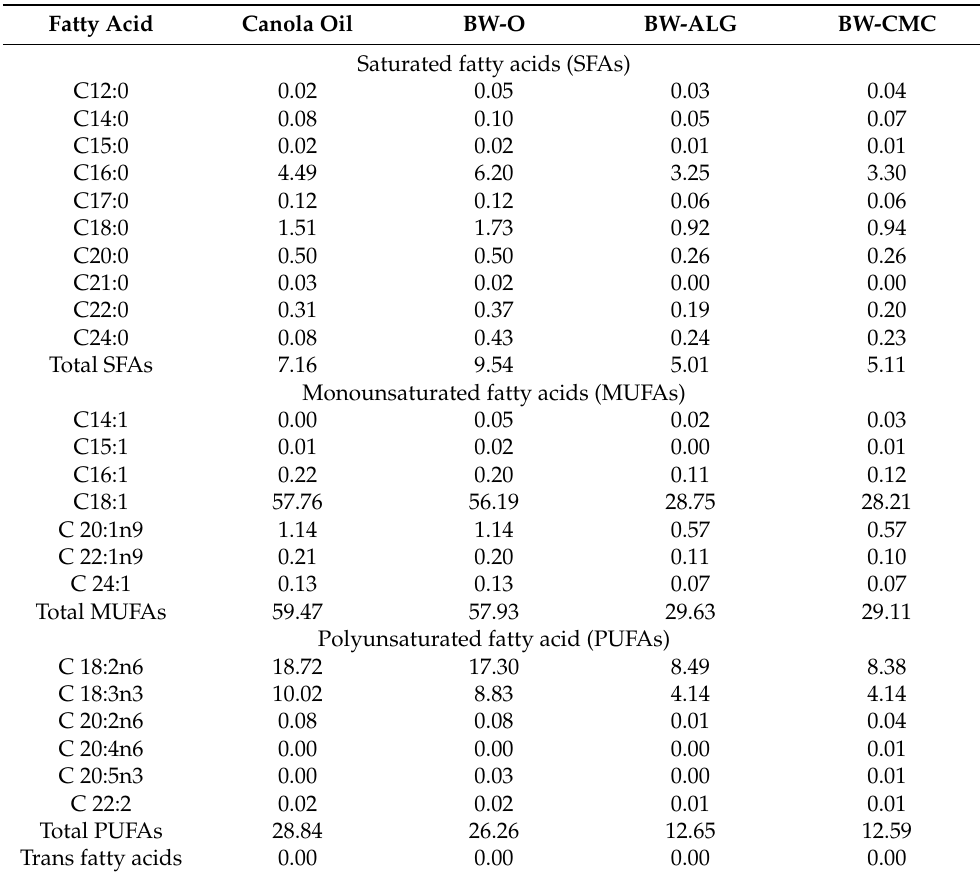
Table 1. Fatty acid profile (g/100 g of sample) of analyzed